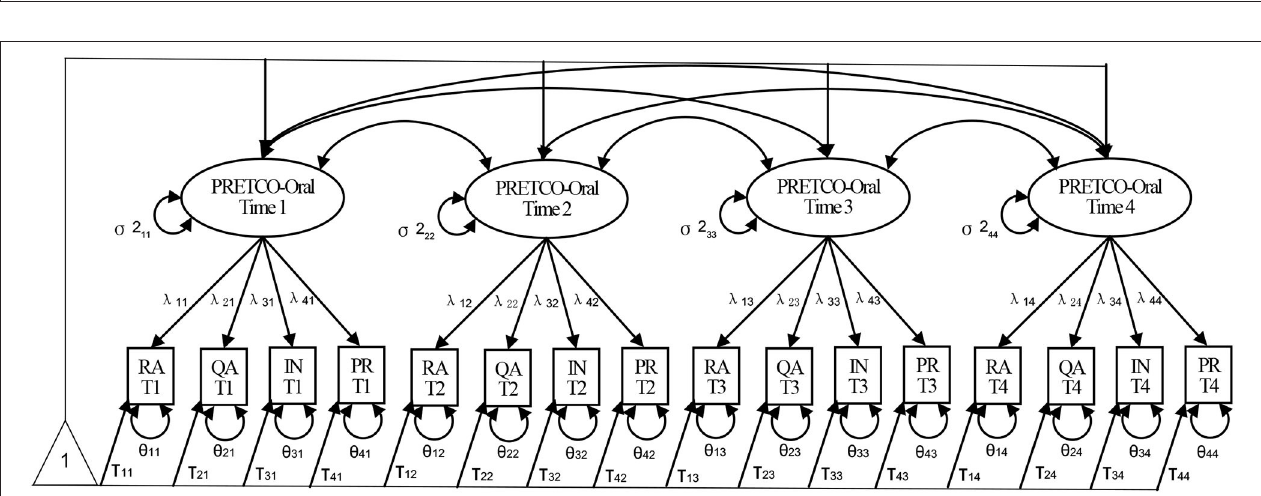
FIGURE 2 | Longitudinal confirmatory factor model for PRETCO-Oral. σ 2 , λ , τ , and θ refer to variance, factor loading, intercept, and unique factor variance (Widaman et al.,